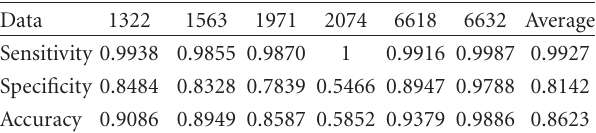
Table 4: The sensitivity, specificity, and accuracy values after SVM classifier.